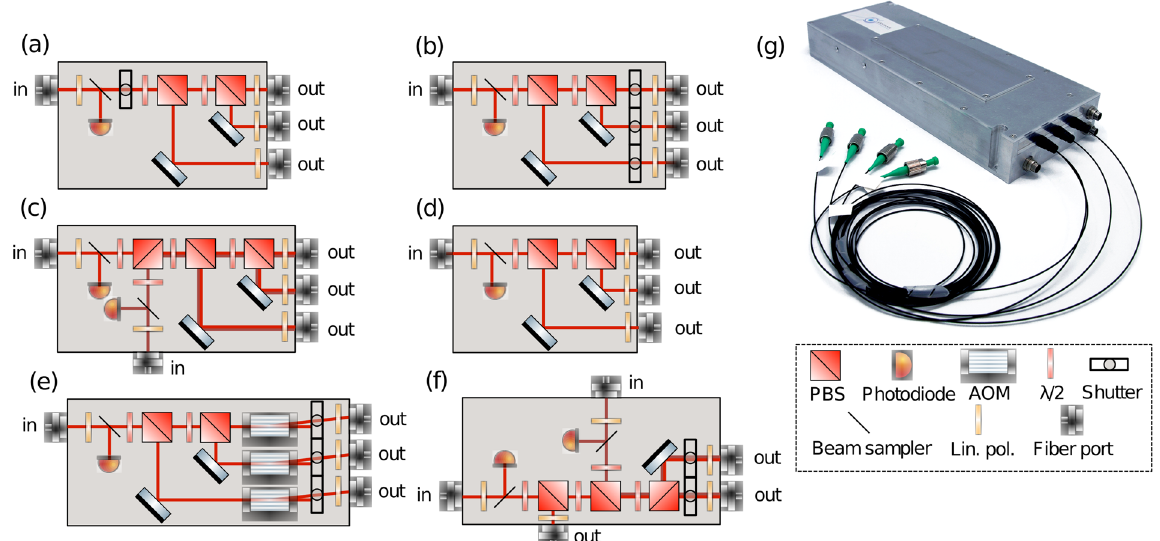
Figure 3. Schematic of all micro-optic splitter/combiners employed in the laser system. ( a ) 1 × 3 micro-optic splitter with an internal shutter before splitting, to shutter all beams simultaneously. This is used to split the 2D MOT light. ( b ) 1 × 3 micro-optic splitter with internal shutters after splitting, to shutter all beams separately. This is used to split light from Repump/Raman 1 when tuned to the repump transition. ( c ) 2 × 3 micro-optic splitter/combiner for combining two beams together, in the same polarization, into a PM fiber. This device is for the bottom three beams of the 3D MOT, with the repump frequency combined into the beams. ( d ) 1 × 3 micro-optic splitter. This variant is used to split a beam for the upper three beams of the 3D MOT. ( e ) 1 × 3 micro-optic splitter with AOMs and internal shutters after splitting, for amplitude and frequency control of each beam. This is the device that gives control over the 3D MOT beams and detection. ( f ) 2 × 3 micro-optic splitter/ combiner with shutters. This variant serves two purposes, to split/combine the Raman frequencies together into two fibers as well as manage a modest pick off to send repump light to other splitter/combiners, namely ( b ) and ( c ). ( g ) Photo of a hermetically sealed, configuration ( c ) micro-optic module. Bottom right; a key for optical